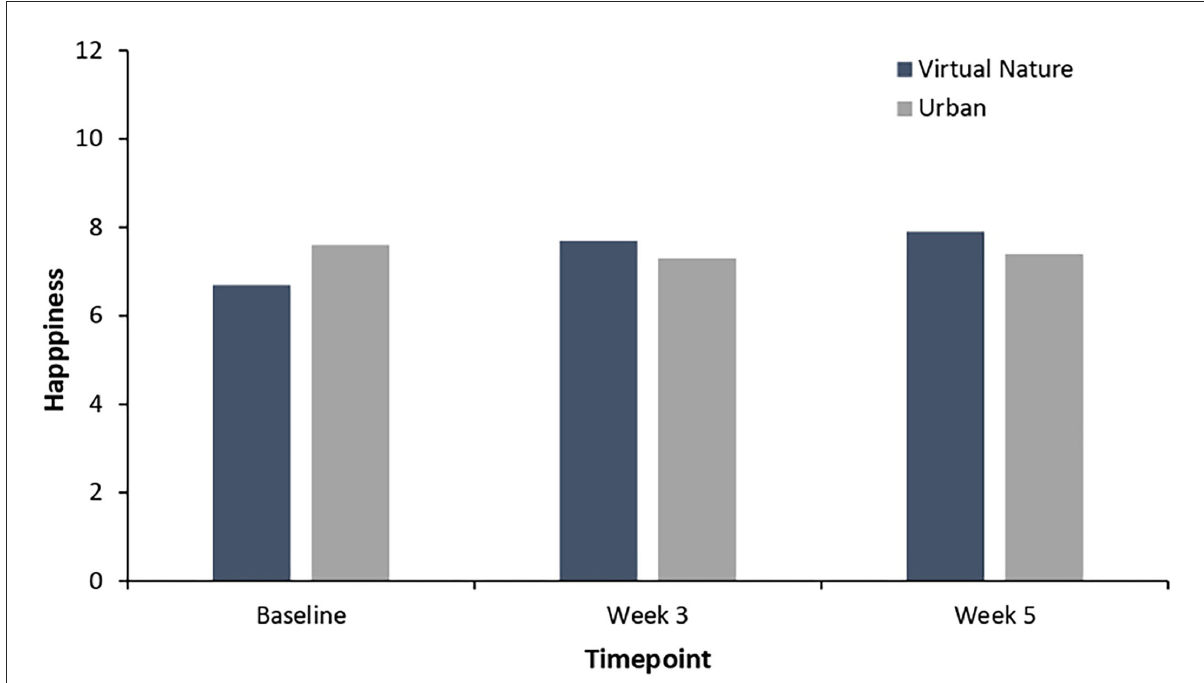
FIGURE3 Happiness in the virtual nature group and urban group from baseline, week 3 and week 5. Levels of happiness in the virtual nature group were higher than in the urban group in week 3 and week 5. There was an increase in happiness in week 3 and week 5 over